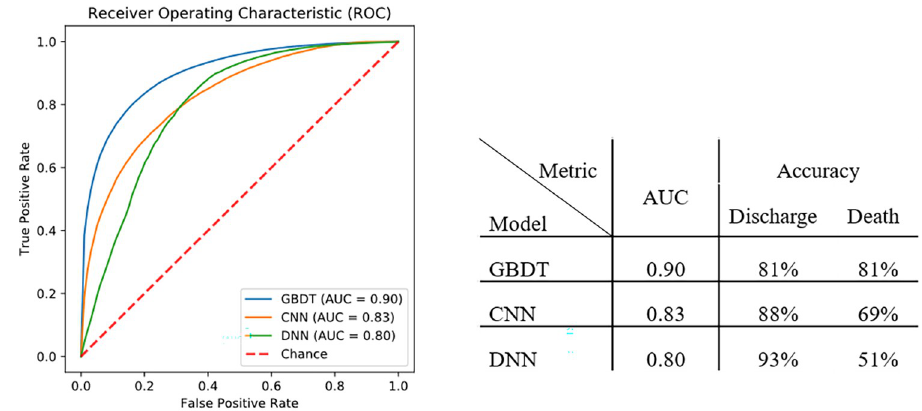
Fig 5. ML models performance in predicting patient